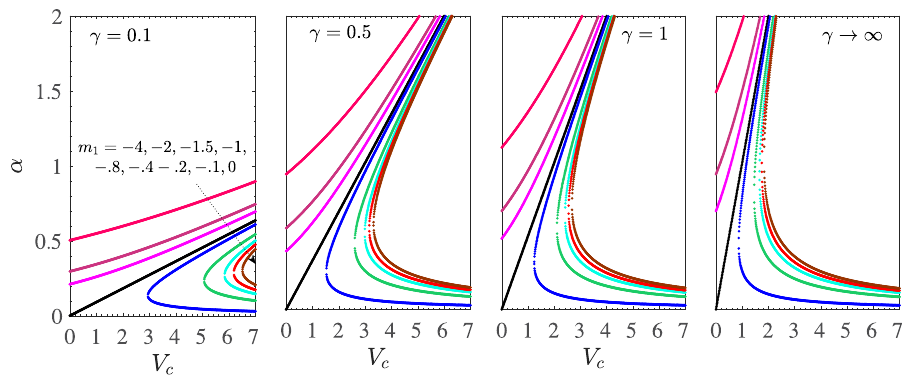
Fig 2. α vs V for M = 0, γ 1 = 0.1 = − γ 2 , d = − (1 + m 1 ) for the shrinking sheet case with mass suction. c